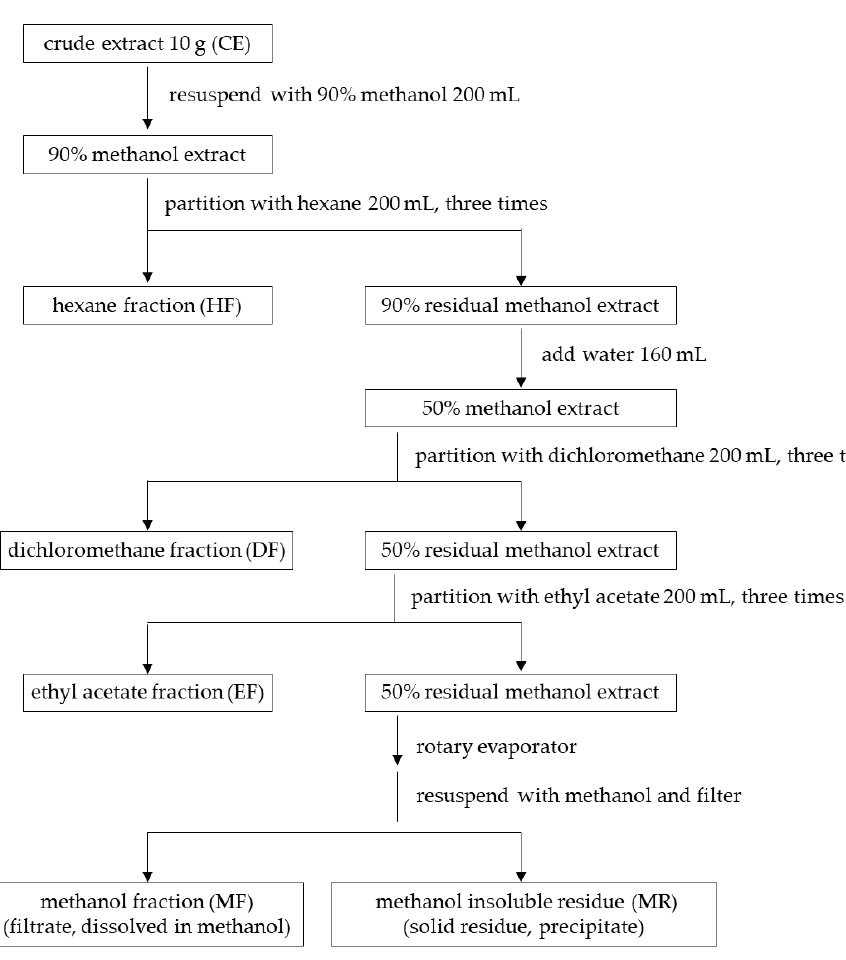
Figure 1. Partitioning of E. debile crude extract (CE) to obtain fractions hexane (HF), dichloromethane (DF), ethyl acetate (EF), methanol (MF), and methanol insoluble residue (MR).